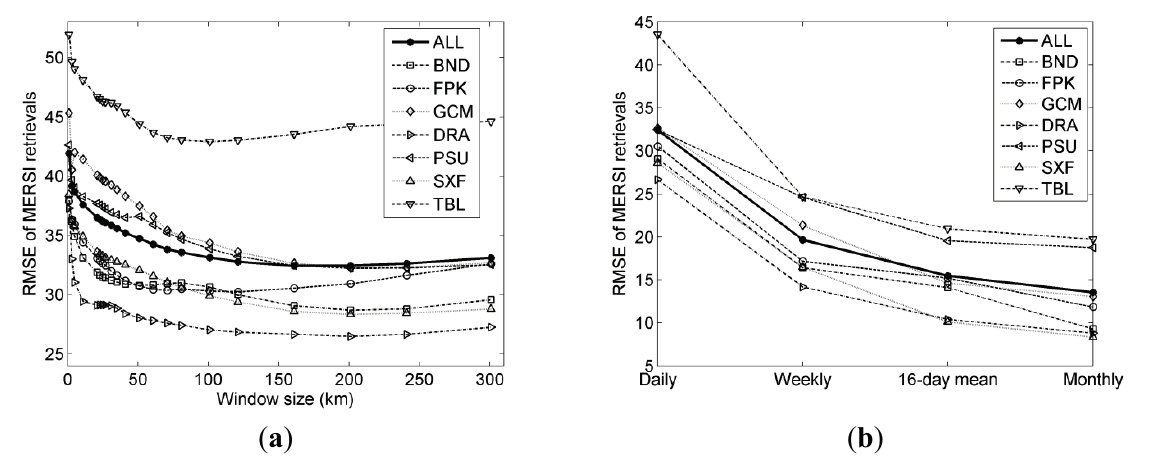
Figure 1. Change of RMSE of estimating daily surface shortwave net radiation (SSNR) from MERSI with spatial ( a ) and temporal ( b ) resolutions. Please see Table 3 for the full names of SURFRAD